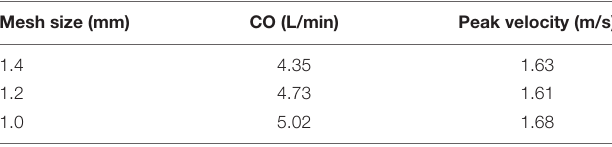
TABLE 1 | Mesh convergence analysis for fluid domain of cardiac output and peak velocity for TAV model.